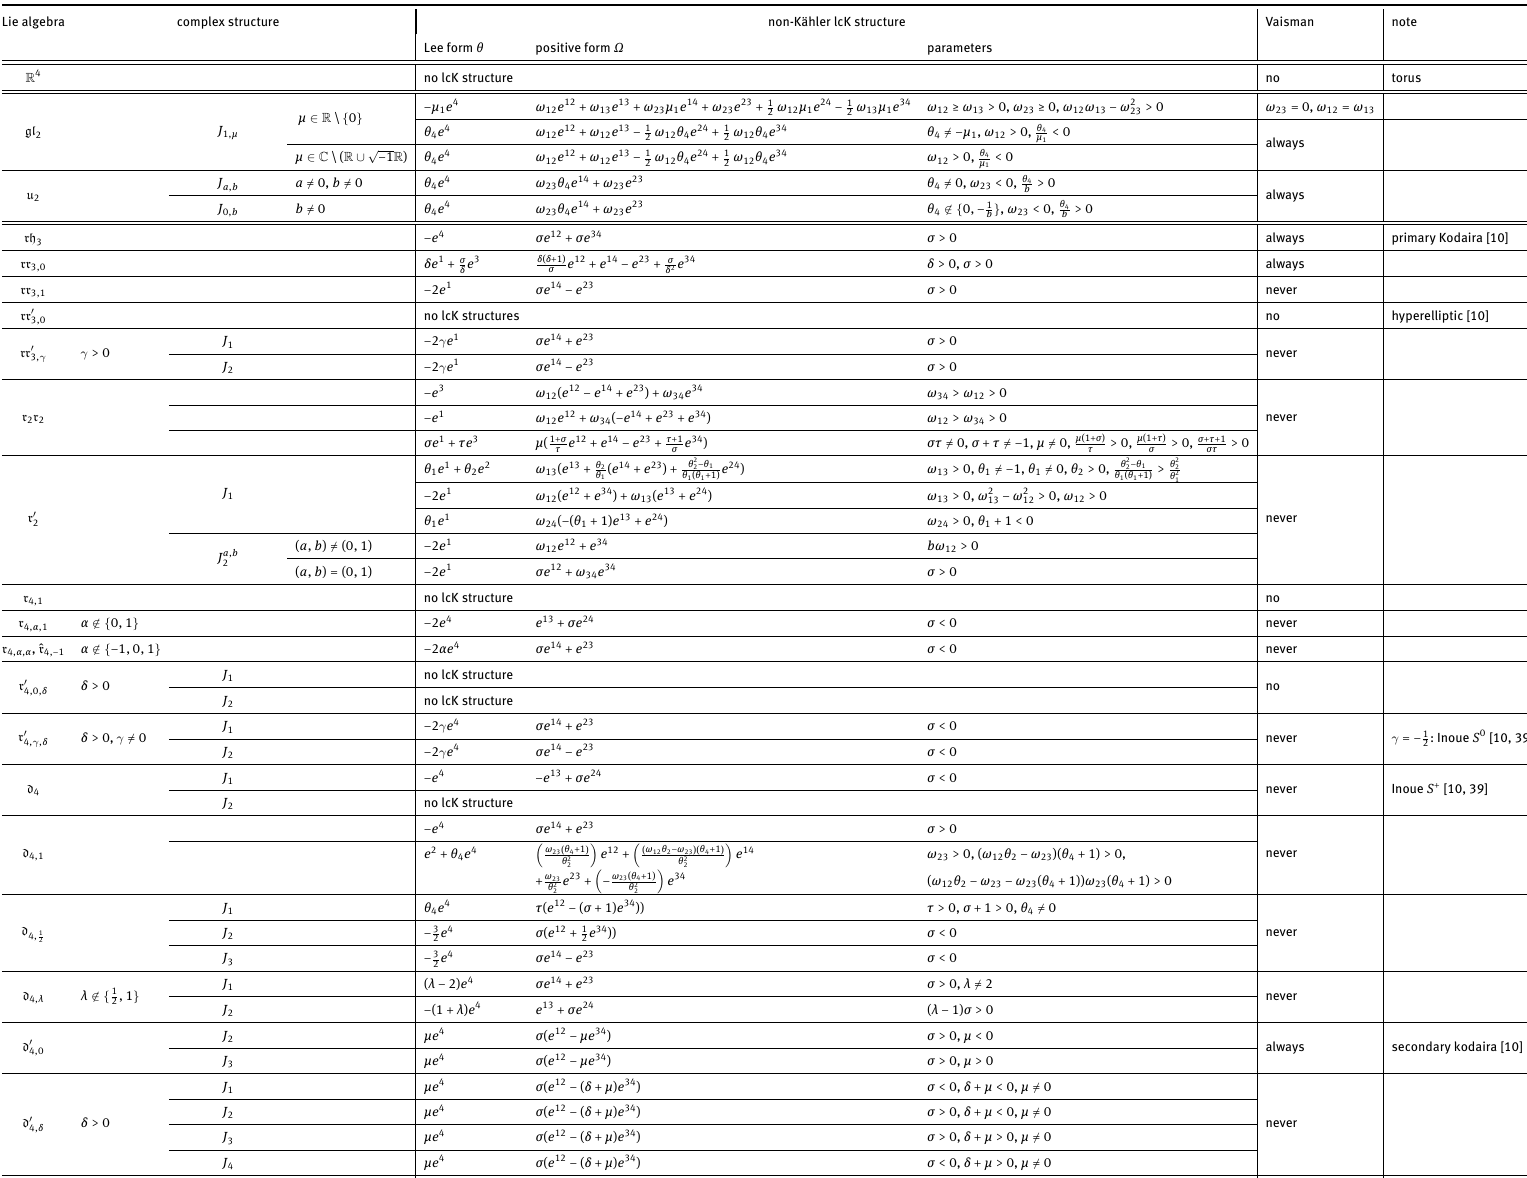
Table 2: Locally conformally Kähler non-Kähler structures on 4 -dimensional Lie algebras, up to complex automorphisms of the Lie algebra. Liealgebra complexstructure